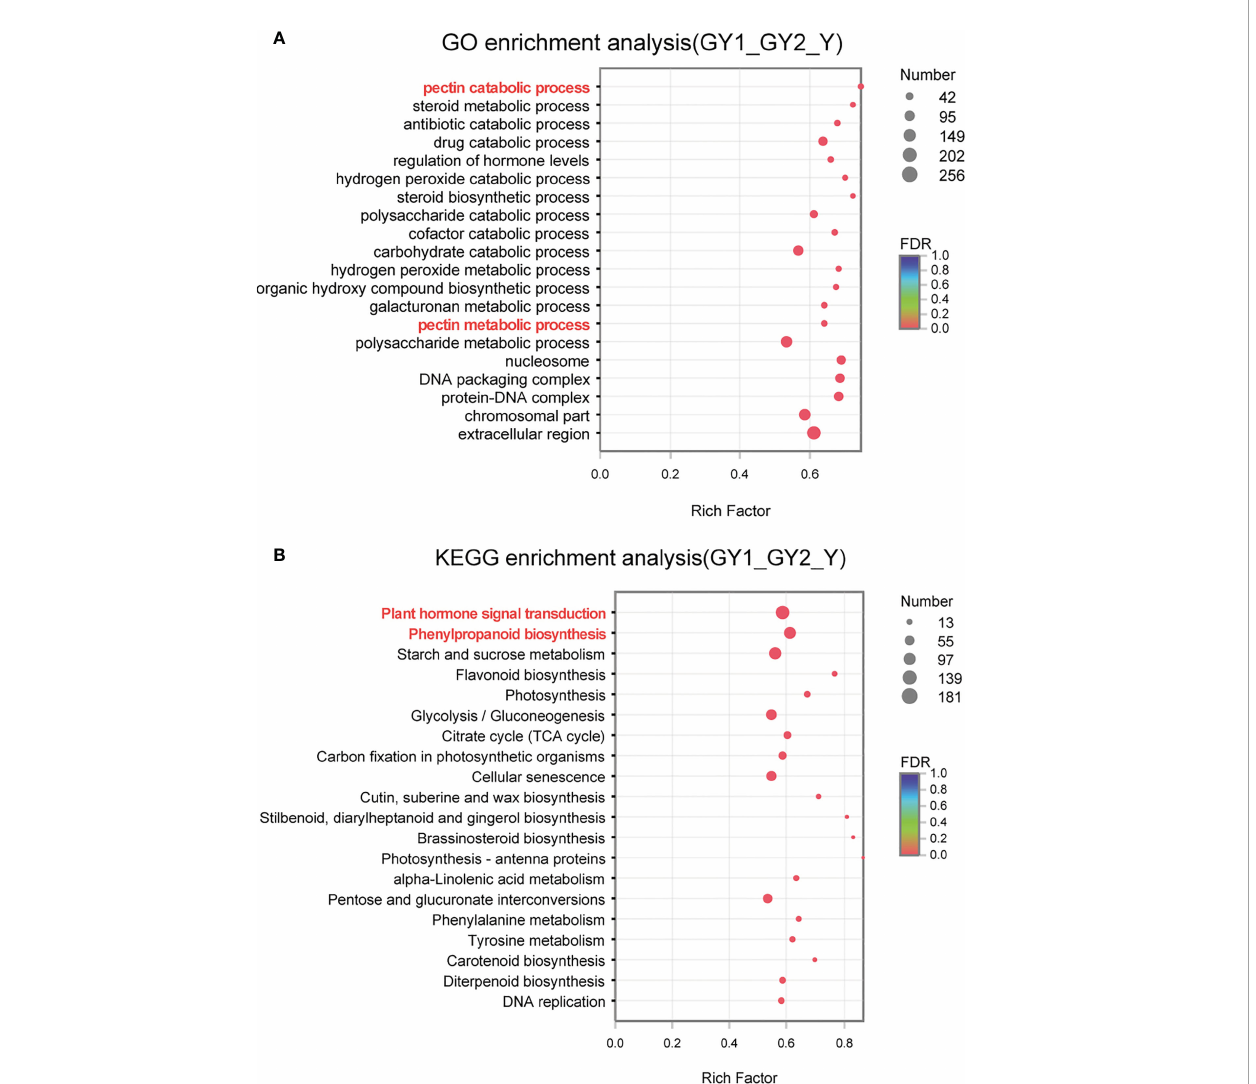
FIGURE 4 Gene Ontology (GO) and Kyoto Encyclopedia of Genes and Genomes (KEGG) enrichment analysis of differentially expressed genes (DEGs) detected in comparisons of the GY1, GY2, and Y stages of anther development. (A) GO enrichment analysis of DEGs. The vertical axis represents the GO term, and the horizontal axis represents the rich factor, the ratio of the number of enrichments to the number of annotations in the GO term. (B) KEGG enrichment analysis of DEGs. The vertical axis represents the pathway name, and the horizontal axis represents the rich factor, the ratio of the number of enrichments to the number of nodes in the